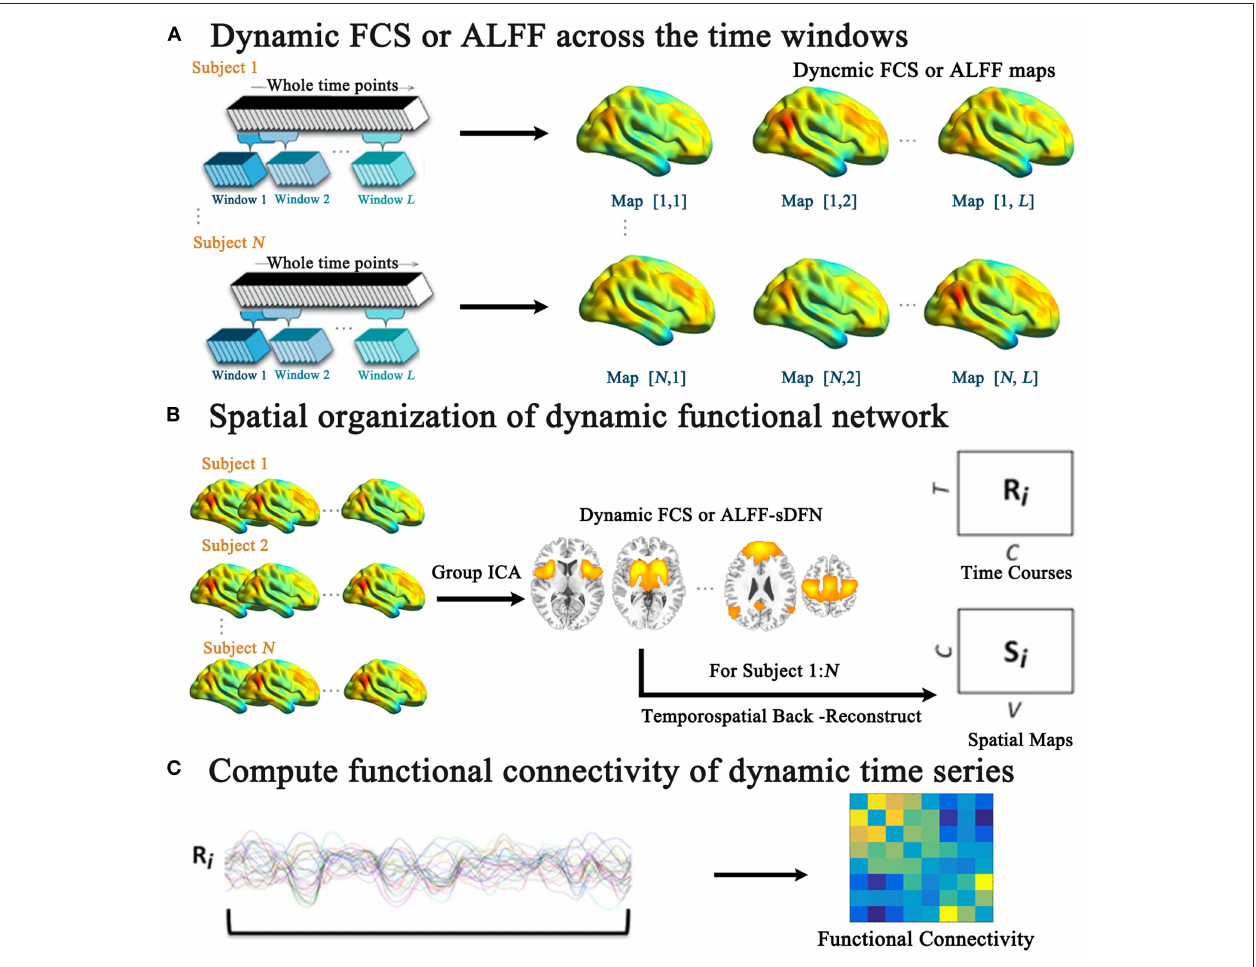
FIGURE 1 | The schematic of the investigated aberrant spatial organization of dynamic functional network (sDFN) across windows in schizophrenia. (A) Denotes the sliding-window-based dynamic functional connectivity strength (FCS) or dynamic amplitude of low-frequency fluctuation (ALFF) analyses for each subject. Within (B) , the group spatial ICA was performed for dynamic FCS and ALFF maps across windows, respectively. (C) Denotes the functional connectivity calculation among the dynamic time series of sDFN.